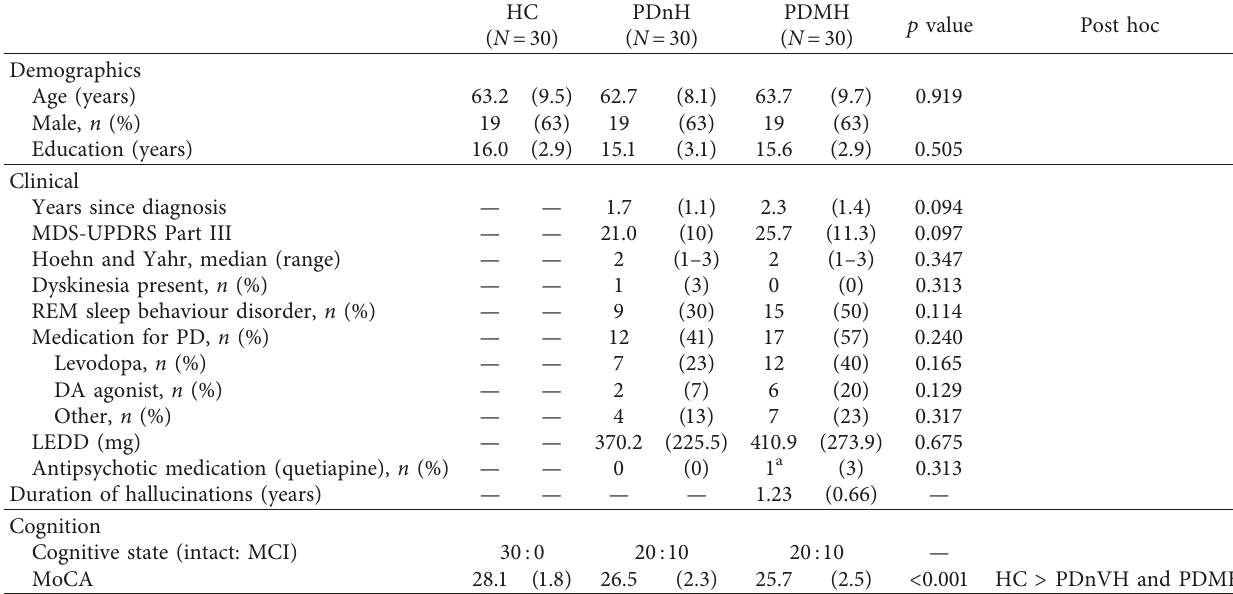
Table 1: Demographic and clinical